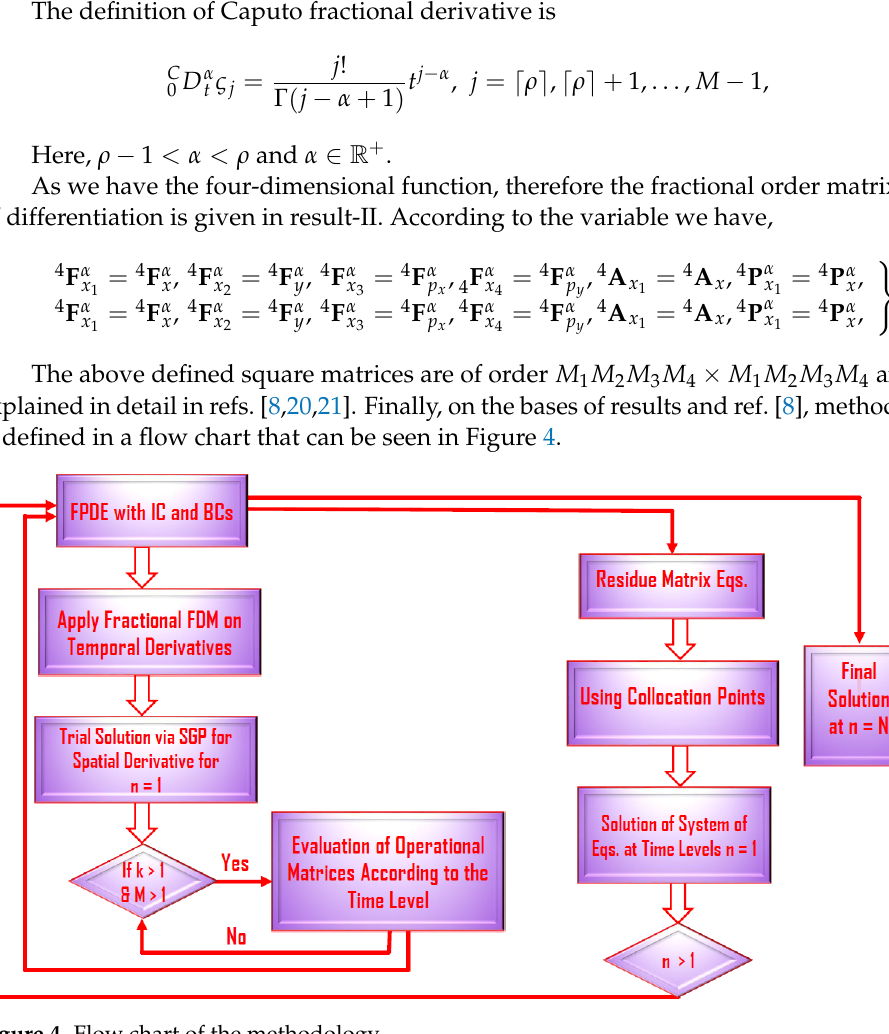
Figure 4. Flow chart of the methodology.